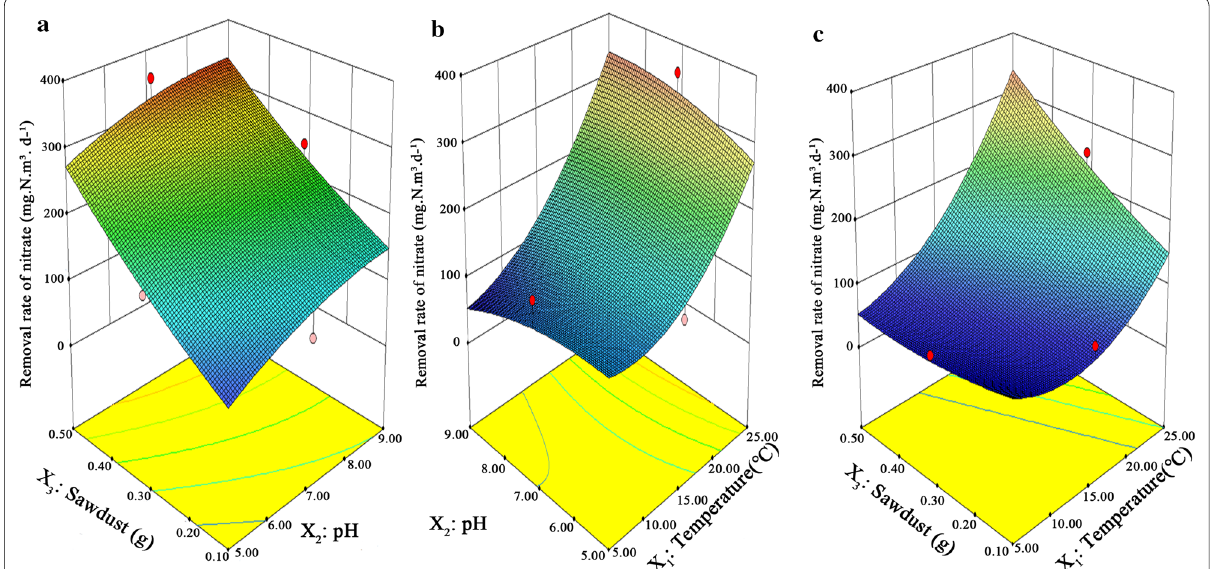
Fig. 2 Removal efficiency of nitrate under different conditions. a Changes of nitrate removal efficiency in response to treatments with different sawdust contents and pH; b changes of nitrate removal efficiency in response to treatments with different temperatures and pH; c changes of nitrate removal efficiency in response to treatments with different sawdust contents and